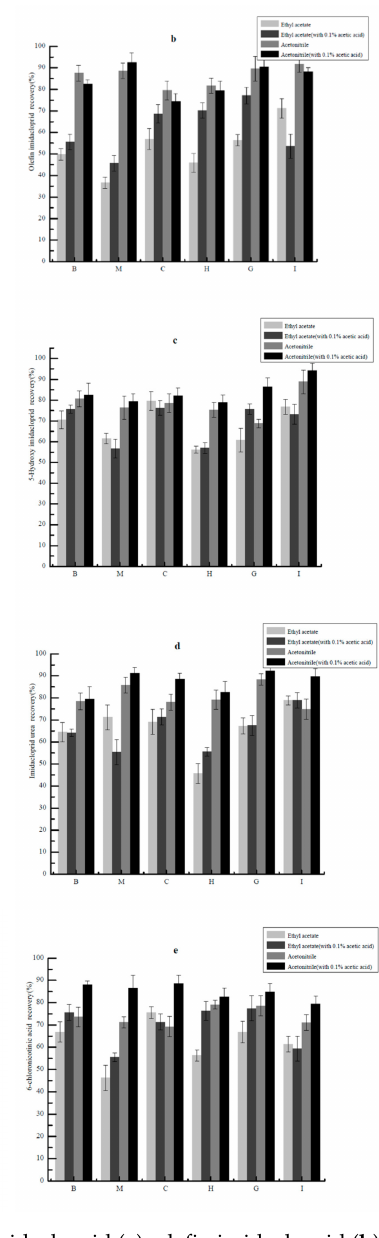
Figure 4. Recoveries of extractions of imidacloprid ( a ), olefin imidacloprid ( b ), 5-hydroxy imidaclo- prid ( c ), imidacloprid urea ( d ) and 6-chloronicotinic acid ( e ) using ethyl acetate and acetonitrile in the presence and absence of 0.1% acetic acid as indicated from the following Procambarus clarkii matrices: B, blood; M, muscle; C, cephalothorax; H, hepatopancrea; G, gills; I,